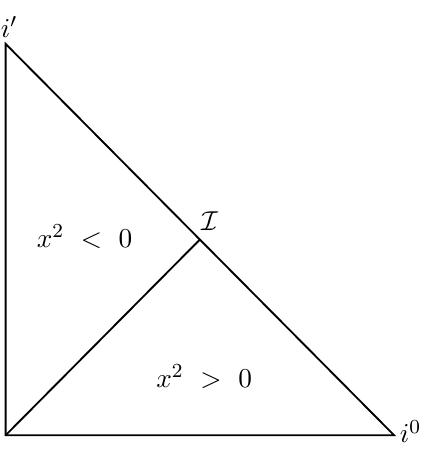
Figure 1 . The toric Penrose diagram for (2,2)-signature Klein space. Each point represents a nondegenerate Lorentzian torus, except the vertical (horizontal) boundary where the spacelike (timelike) cycle of the torus